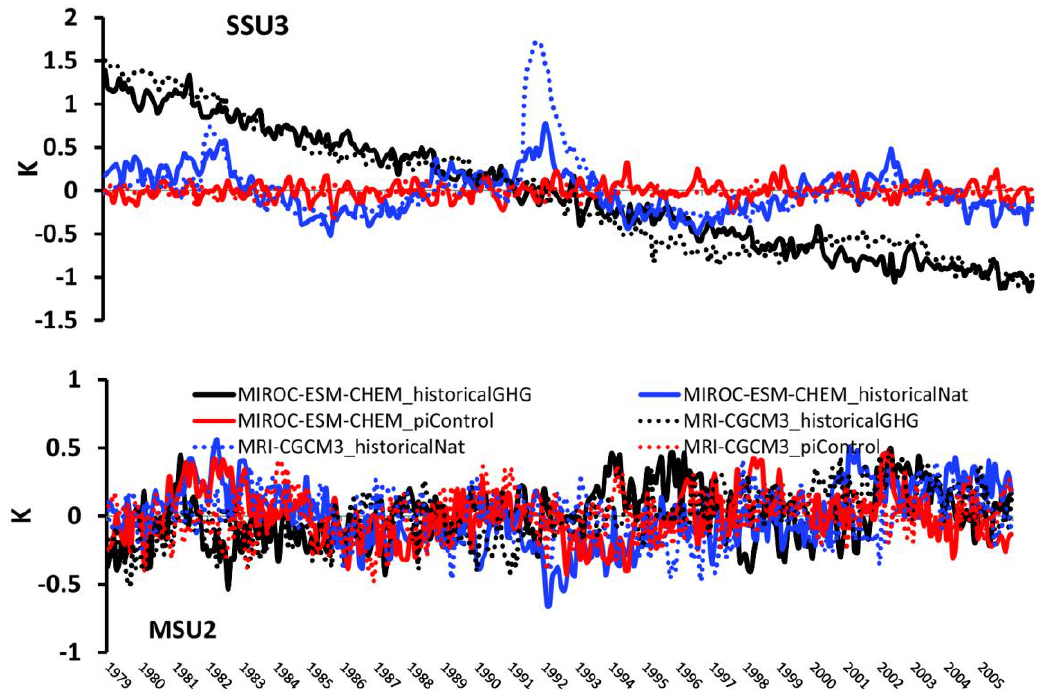
Figure 7. Global mean temperature anomalies for SSU3 and MSU2 observational layers in GHG-only historical experiment, Natural-only forcing run and preindustrial control run.